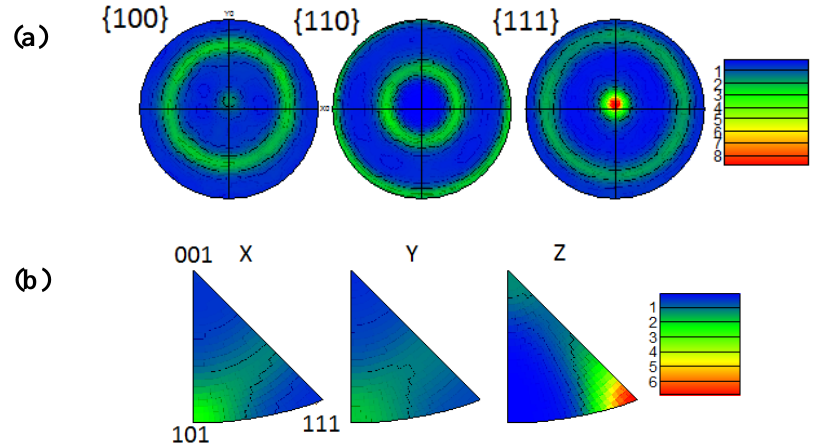
Figure 9. ( a ) The pole and ( b ) inverse pole figures measured by electron back scattered diffraction (EBSD) on swaged RR1000. Intensity (times random orientation) indicated by the colour keys in each case.